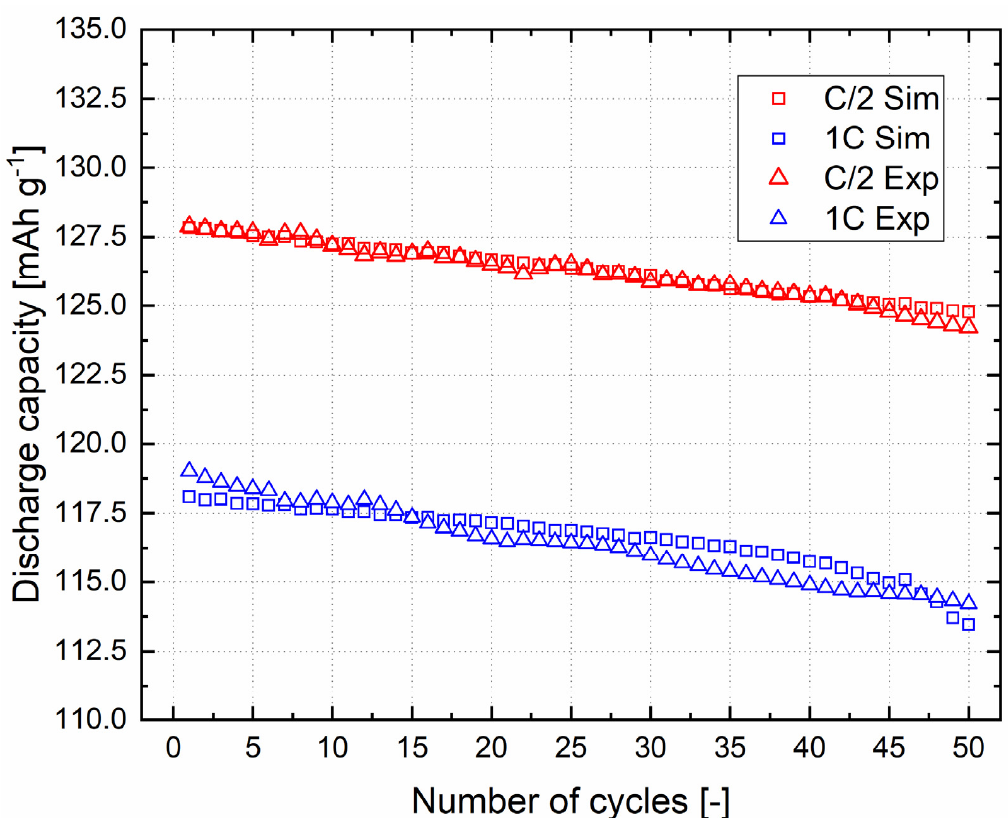
Figure 5. Validation of the aging model. Instead, the capacity loss values calculated for the simulated curves are 2.39% and 3.92% for C/2 and 1C, respectively. This means that there is a difference between